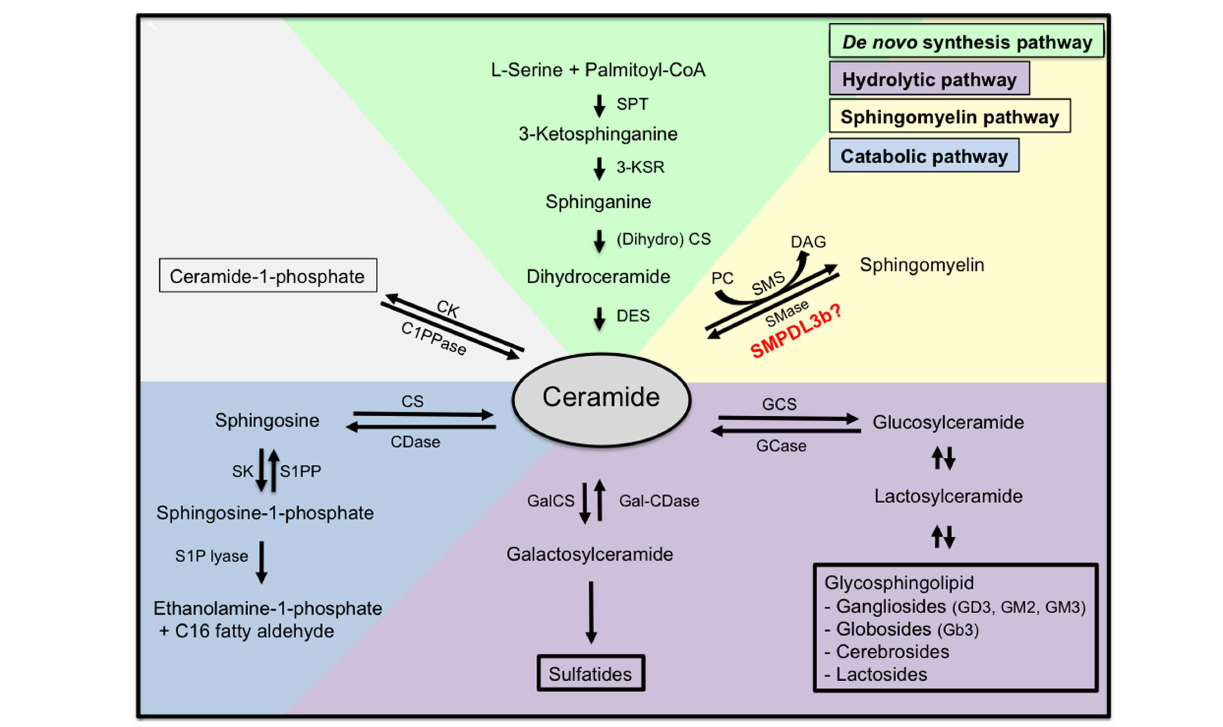
FIGURE 2 | Sphingolipid metabolism . Ceramide is the centerpiece of the sphingolipid metabolic pathway and can be synthesized de novo from L-serine and palmitoyl-CoA (green), through hydrolysis of sphingomyelin (yellow), or through hydrolysis of glycosphingolipids and sulfatites (purple). Ceramide can also be synthesized from sphingomyelin through the action of sphingomyelinases, or from ceramide-1-phosphate through the action of ceramide-1-phosphate phosphatase. Finally, ceramide can be further catabolized (blue) to sphingosine and sphingosine-1-phosphate, which are biologically active metabolites and finally to ethanolamine-1-phosphate and